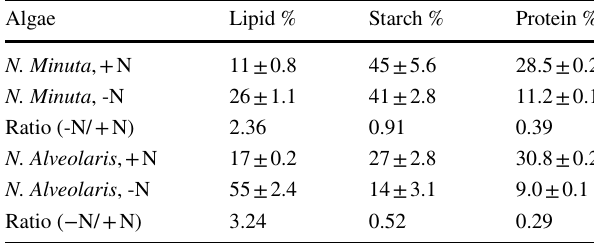
Table 1 Biomass composition after 10 days of growth of N. minuta and N. alveolaris algae cells in nitrogen-rich (+ N) and